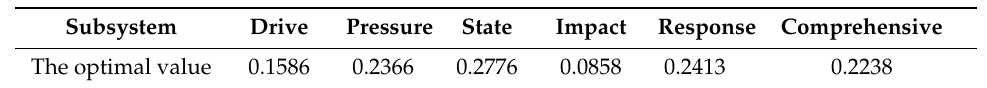
Table 5. Weights for each